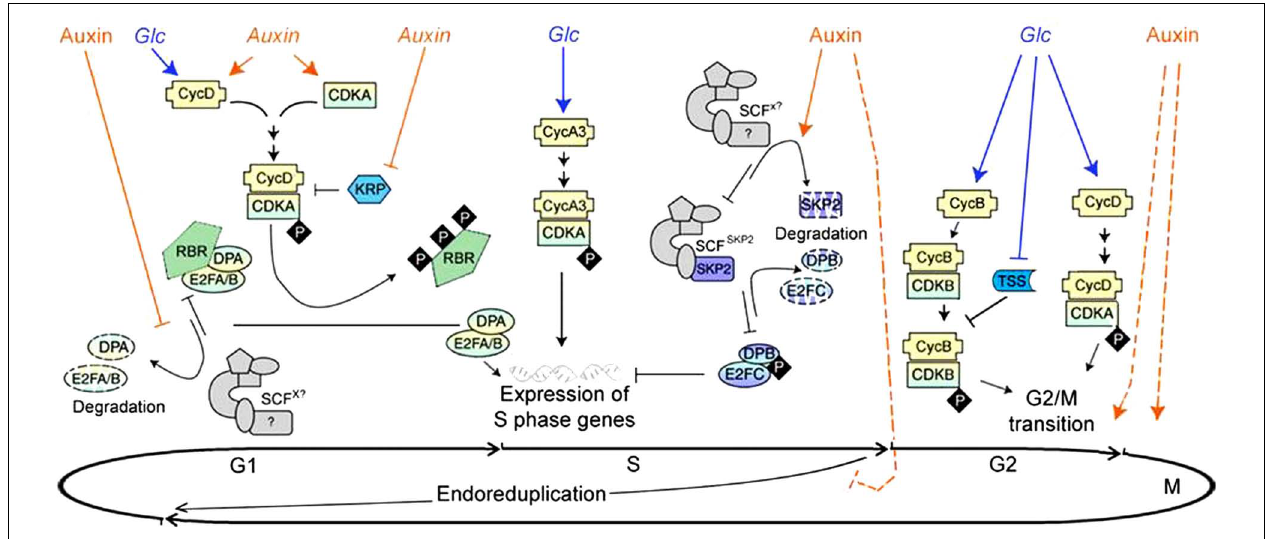
FIGURE 1 | Glucose and auxin signal in cell cycle regulation (modified from Perrot-Rechenmann, 2010, Figure 2). The cell cycle is divided into four phases: DNA replication (S), mitosis (M), and two gap phases (G1 and G2, between M/S and S/M, respectively). Some plant cells may skip the M phase under certain developmental processes, resulting “endoreduplication.” Cell cycle starts in G1. During this phase, Glc and auxin signals could induce the expression of CycD , while auxin is also able to increase CDKA transcription.The CycD/CDKA complex is activated by phosphorylation but can still be blocked by CDK inhibitor KRPs. Auxin was reported to reduce the expression of some KRPs .The active CycD/CDKA complex provokes phosphorylation of the transcriptional repressor RBR, and release the transcription regulator E2FA/B and DPA complex. By post-transcriptional regulation, auxin stabilizes the E2FA/B and DPA